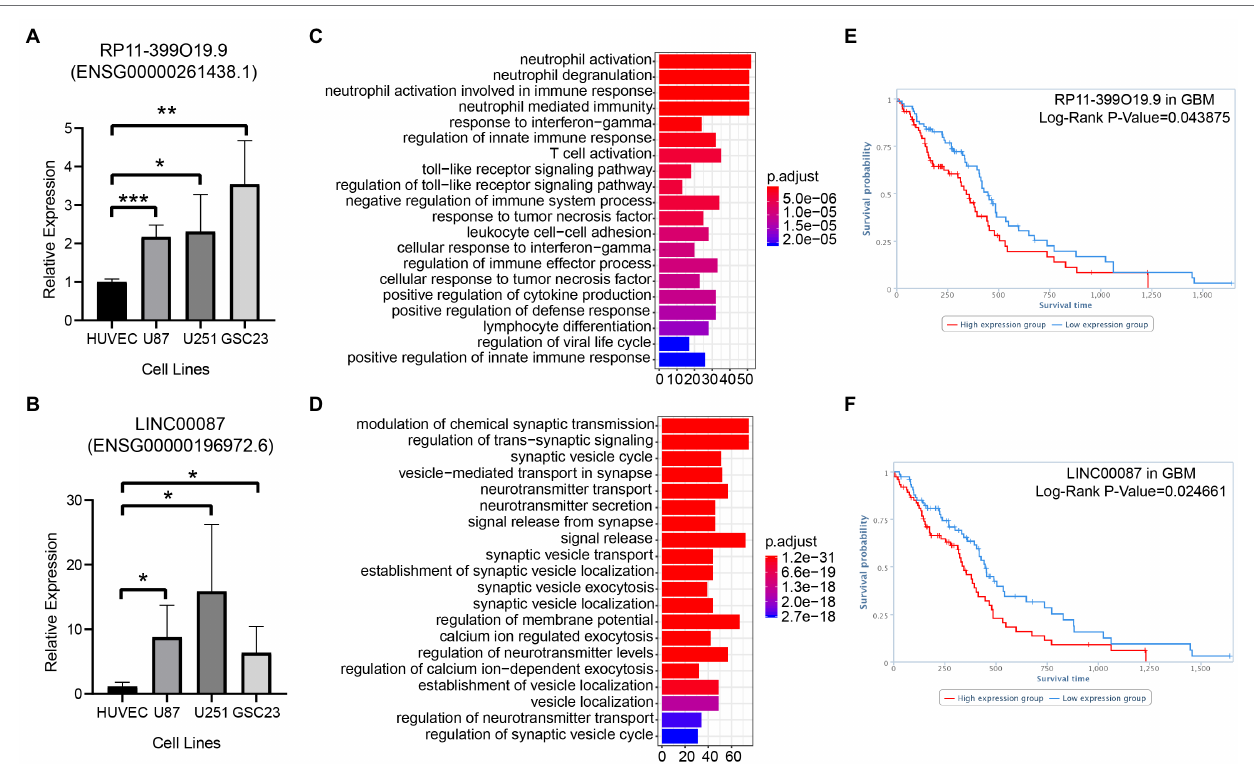
FIGURE 4 | Assess the reliability of candidate LncRNAs by the examination of RP11-399O19.9 and LINC00087 in GBM. (A) mRNA expression of RP11-399O19.9 and (B) LINC00087 in HUVEC, U87MG, U251MG, and GSC23 cell lines (*means p < 0.05, **means p < 0.01, and ***means p < 0.001). (C) GO annotation of RP11-399O19.9 and (D) LINC00087. (E) Kaplan–Meier survival analysis of RP11-399O19.9 and (F) LINC00087 in GBM